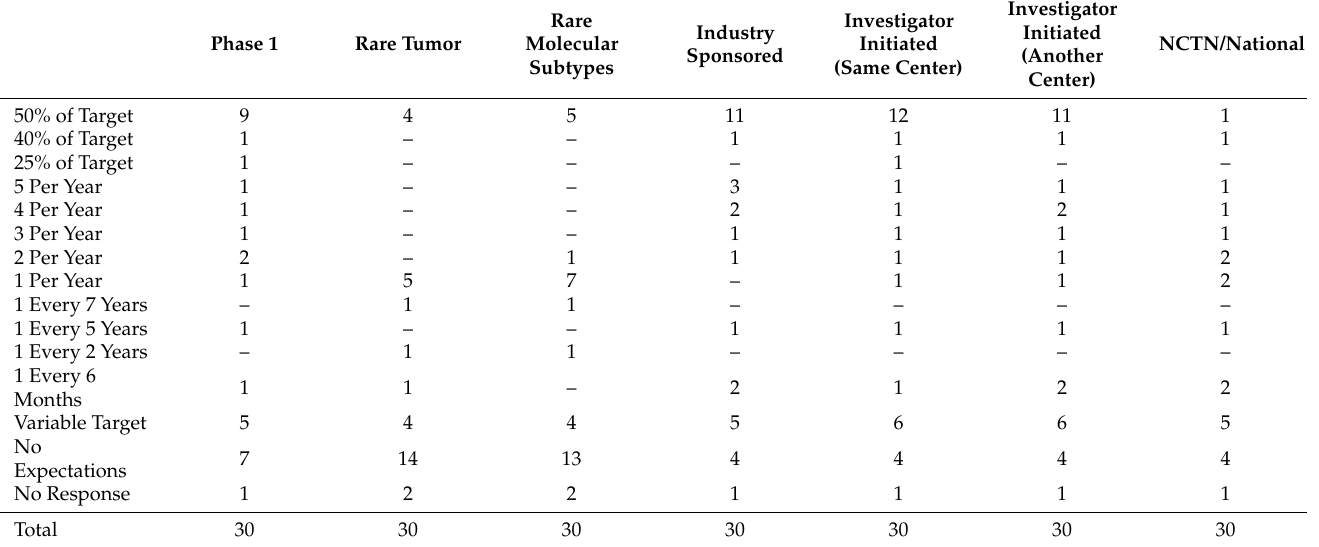
Table 2. PRMC minimum accrual expectations by study category.